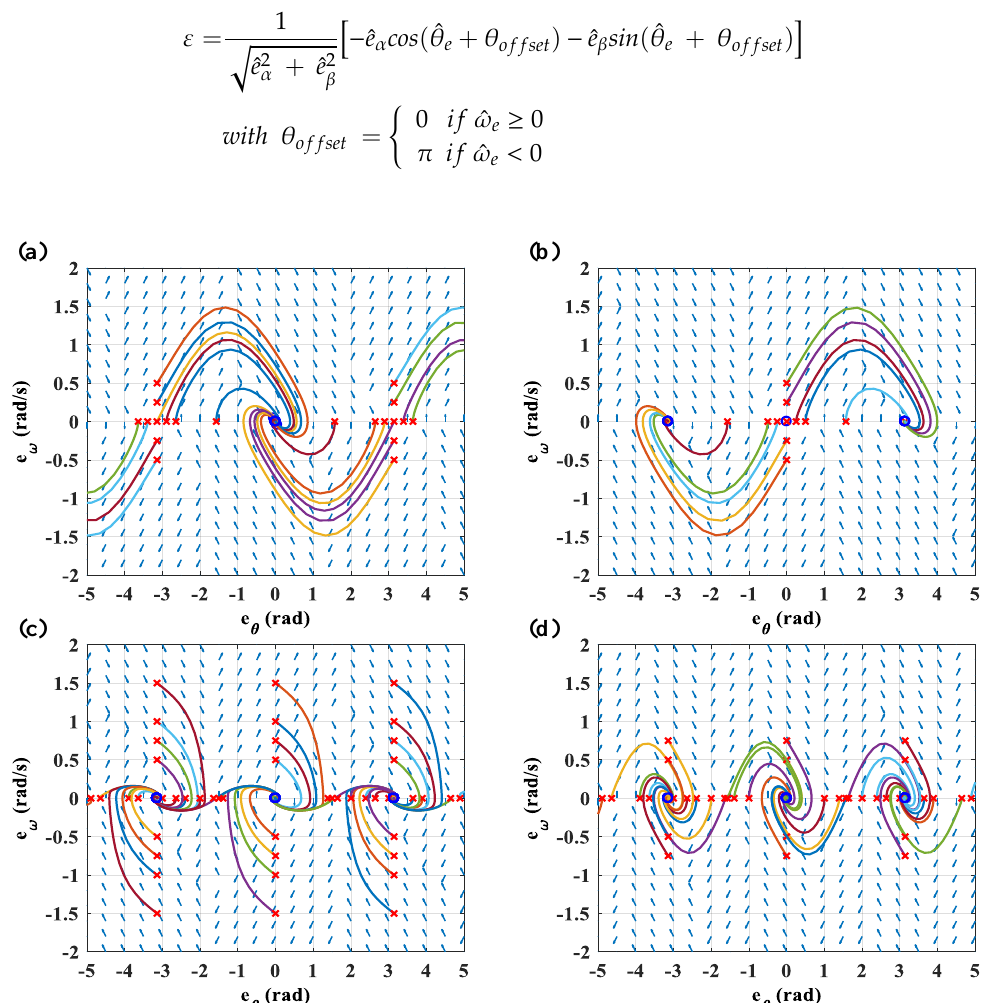
Figure 3. The phase portrait of: ( a ) the conventional PLL for positive rotor speed; ( b ) the conventional PLL for negative rotor speed; ( c ) the tangent-based PLL for both positive and negative rotor speed; and ( d ) the back EMF (electromotive force) signal reconstruction-based PLL for both positive and negative rotor speed.